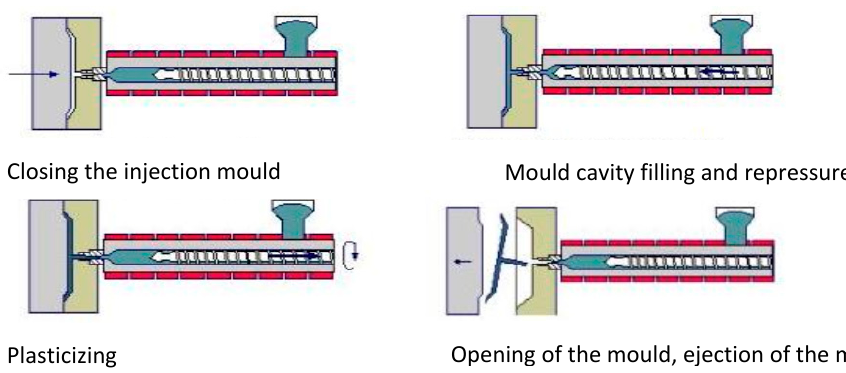
Figure 1. Plastic injection cycle [20].